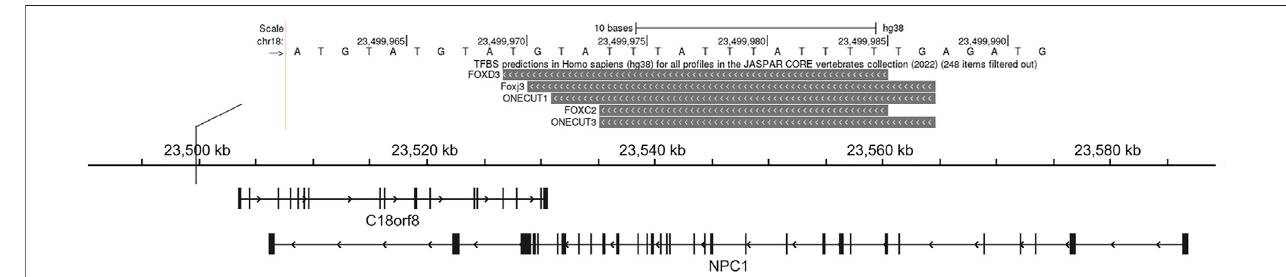
FIGURE7| Transcriptionfactorprediction.ThisUCSCGenomeBrowsertrackhubrepresentsgenome-widepredictedbindingsitesfortranscriptionfactorbinding pro fi les in the JASPAR database CORE collection, this view only showed predicted binding sites with scores above 500, which indicated the p -value of the TF match to indel position was less than